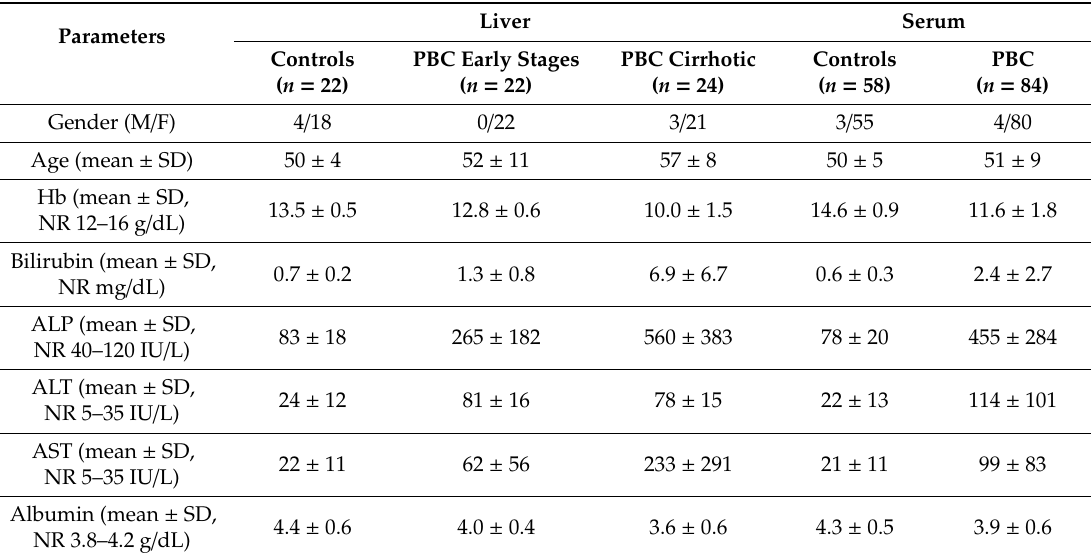
Table 1. Demographic and laboratory features of analyzed